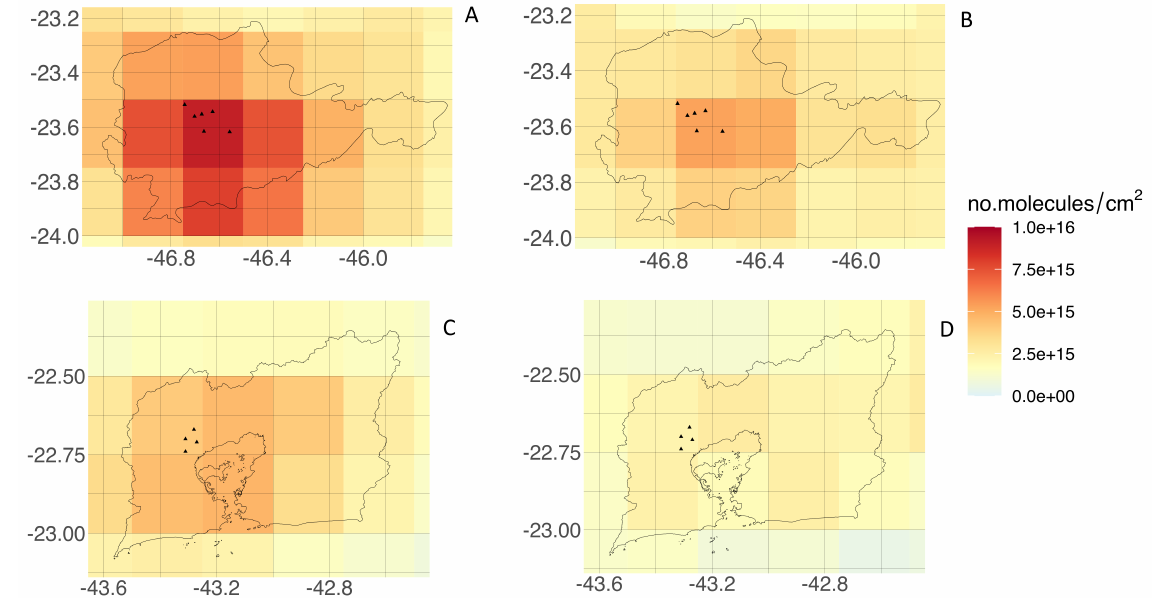
Figure 3. The NO 2 column values during the May months of 2015–2019 in SP ( A ) and RJ ( C ), and during May 2020 in SP ( B ) and RJ ( D